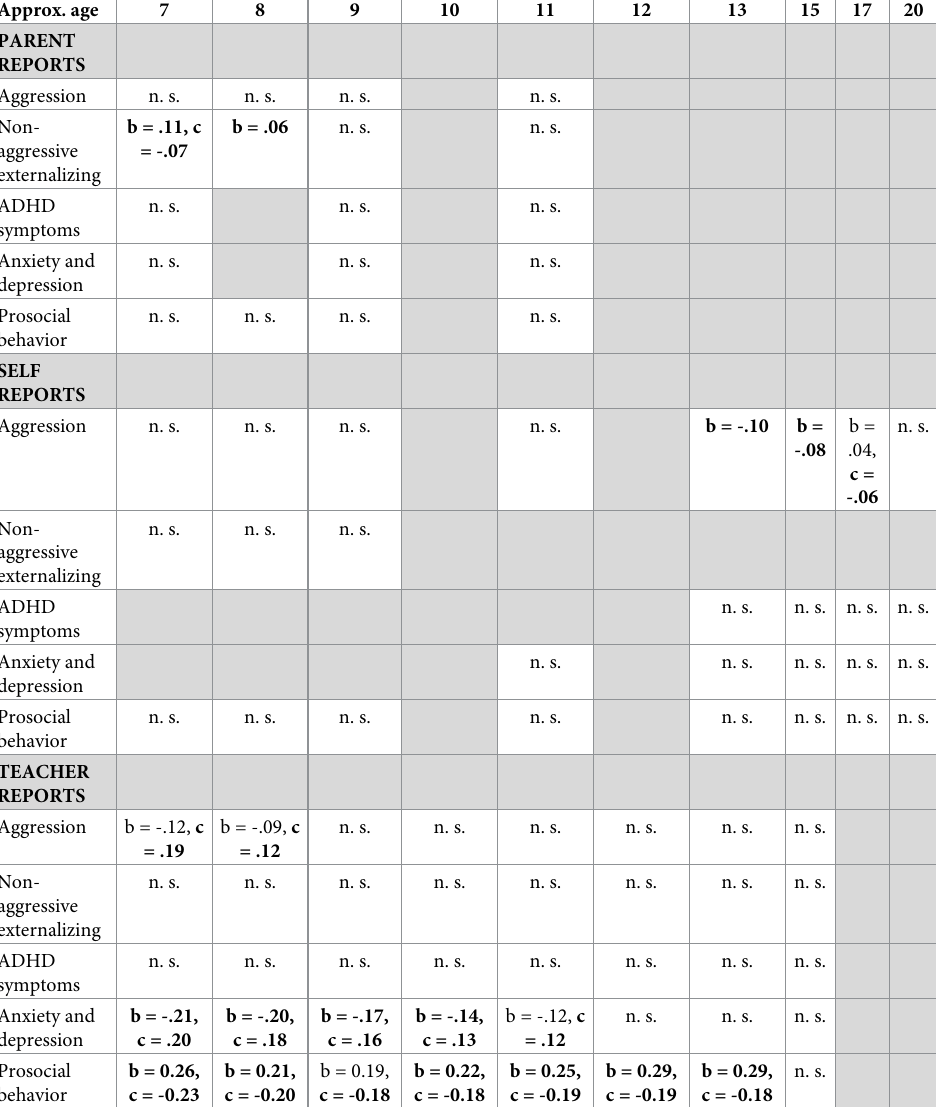
11, and less prosocial behavior at ages 7 through 13. Since children generally do not attend play- groups before age 3, this means in practice that the cut-off was around 3 days per week. Summing up, evidence suggested that daycare center attendance was related to more prob- lem behavior according to the parents and, to some extent, the children themselves. Spending more than two to three days per week at a daycare mother and visiting a playgroup on at least three days per week was related to more externalizing and internalizing behavior and less pro- social behavior according to the teachers. Relations decreased as the children got older.